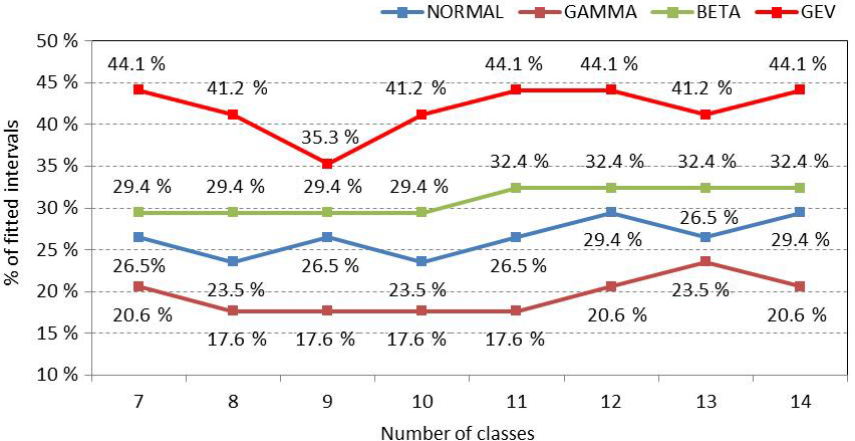
Figure 8. Percentage of fitted intervals ( y axis) for each PDF candidate (normal, gamma, beta and GEV distributions) as a function of the number of classes ( x